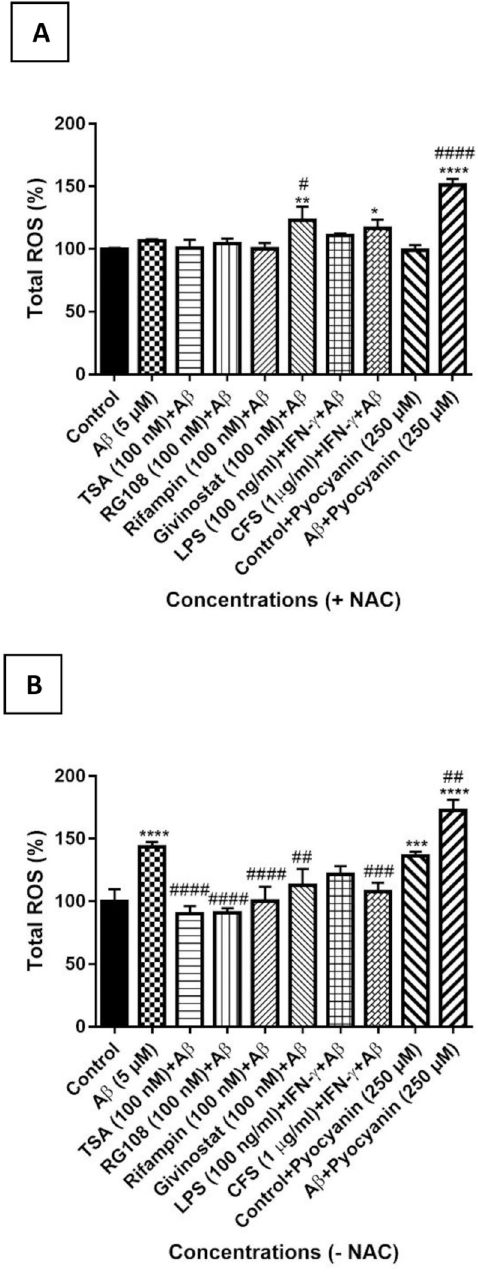
Fig 9. Percentage graph of the total amount of ROS. ROS levels were determined by ELISA method according to the treatment groups (with (A) or without (B) the presence of ROS inhibitor 5 mM N-acetyl cysteine (NAC)). The data represents the means ± SDs of three individual experiments (n = 4 for each). One-way ANOVA was used for statistical analysis, followed by a post hoc Tukey’s multiple comparisons test. no difference: p > 0.05 ns; significant difference: � p < 0.05, �� p < 0.01, ��� p < 0.001 and ���� p < 0.0001 according to the control group; # p < 0.05, ## p < 0.01, ### p < 0.001 and #### p < 0.0001 according to the A β positive control